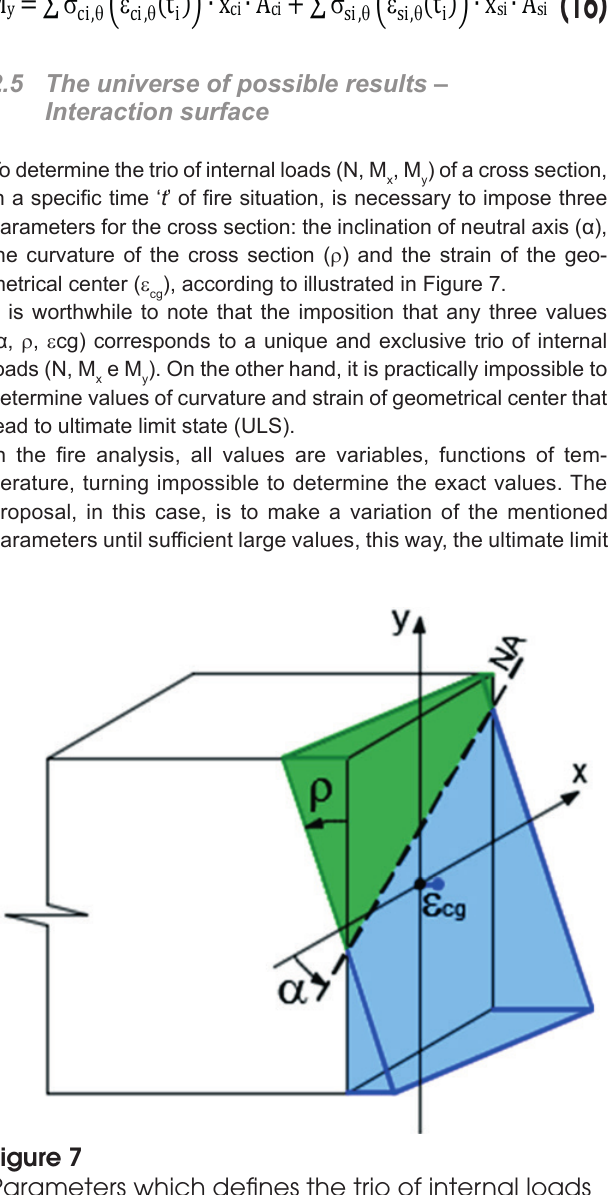
Parameters which defines the trio of internal loads